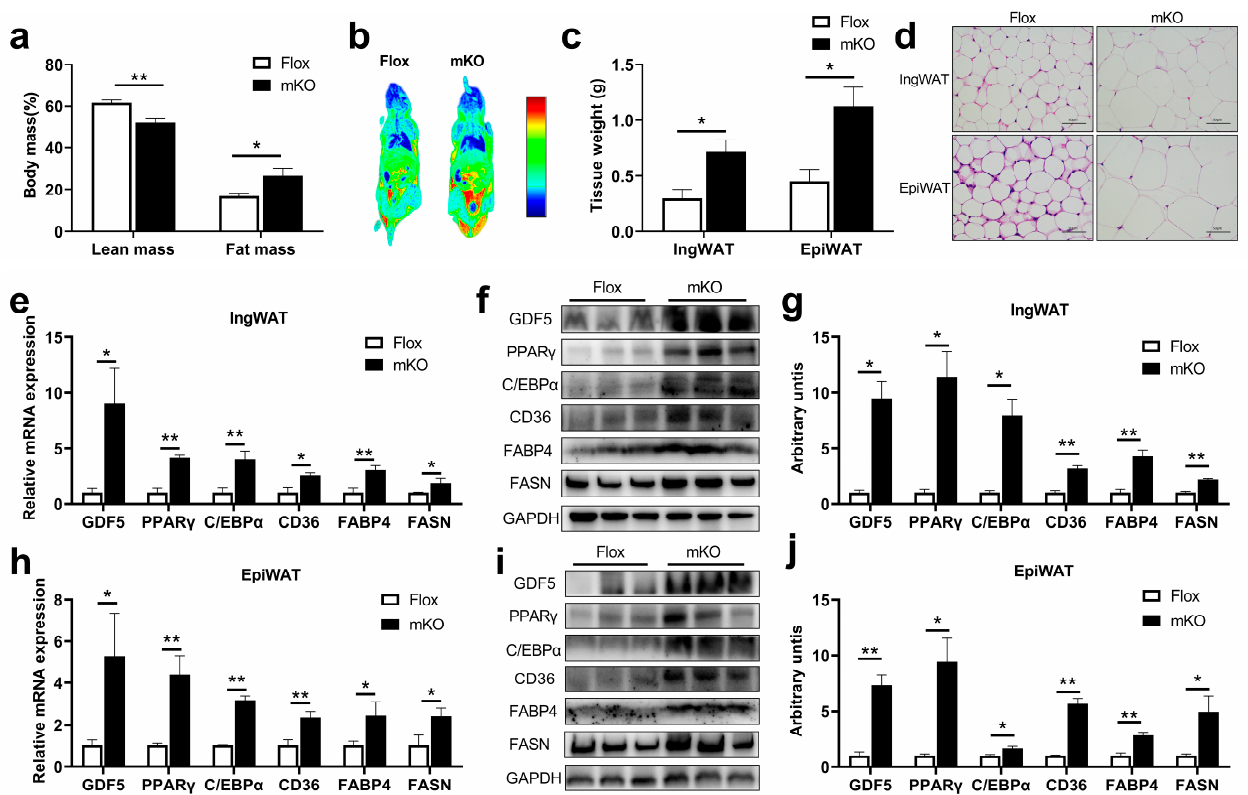
Figure 6. Effects of skeletal muscle-specific miR-146a-5p knockout on adipogenesis in mice. ( a ) Body composition of Flox and mKO mice. ( b ) Body imaging of Flox and mKO mice. ( c ) Tissue weight (IngWAT and EpiWAT) of Flox and mKO mice after feeding with a high-fat diet (HFD) (n = 4). ( d ) HE staining image of IngWAT and EpiWAT in Flox and mKO mice fed with HFD (scale bar = 50 µ m). ( e ) Fluorescence quantitative PCR detection of adipogenesis-related genes GDF5, PPAR γ , C/EBP α , and fatty acid synthesis-related genes CD36, FABP4, FASN in IngWAT of Flox and mKO mice (n = 4). ( f , g ) Western Blot detection of adipogenesis-related proteins GDF5, PPAR γ , C/EBP α , and fatty acid synthesis-related proteins CD36, FABP4, and FASN in IngWAT of Flox and mKO mice (n = 4). ( h ) Fluorescence quantitative PCR detection of adipogenesis-related genes GDF5, PPAR γ , C/EBP α , and fatty acid synthesis-related genes CD36, FABP4, FASN in EpiWAT of Flox and mKO mice (n = 4). ( i , j ) Western Blot detection of adipogenesis-related proteins GDF5, PPAR γ , C/EBP α , and fatty acid synthesis-related proteins CD36, FABP4, FASN in EpiWAT of Flox and mKO mice (n = 4). Values are presented as means ± SEM, * p < 0.05, and ** p < 0.01, according to the non-paired Student’s t -test or one-way ANOVA between individual groups.